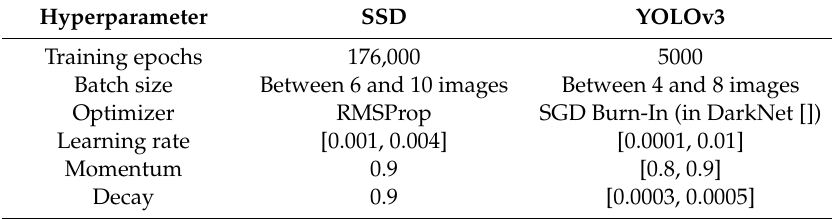
Table 1. Main training hyperparameters used for SSD and YOLOv3